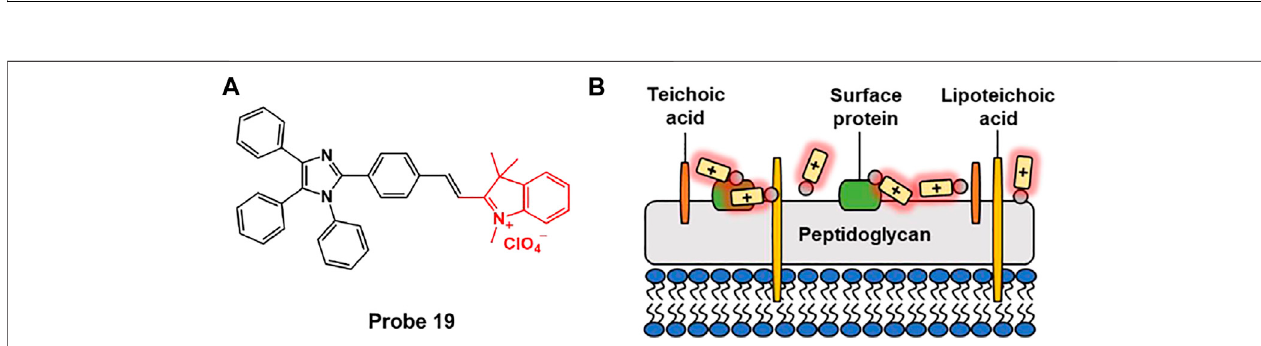
FIGURE 9 | (A) Chemical structures of probe 19. (B) Schematic illustration of probe 19 for Gram-positive bacteria.